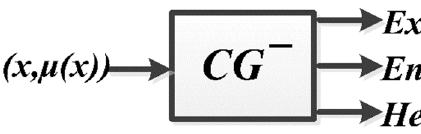
Figure 4. Schematic diagram of inverse cloud generator operation.